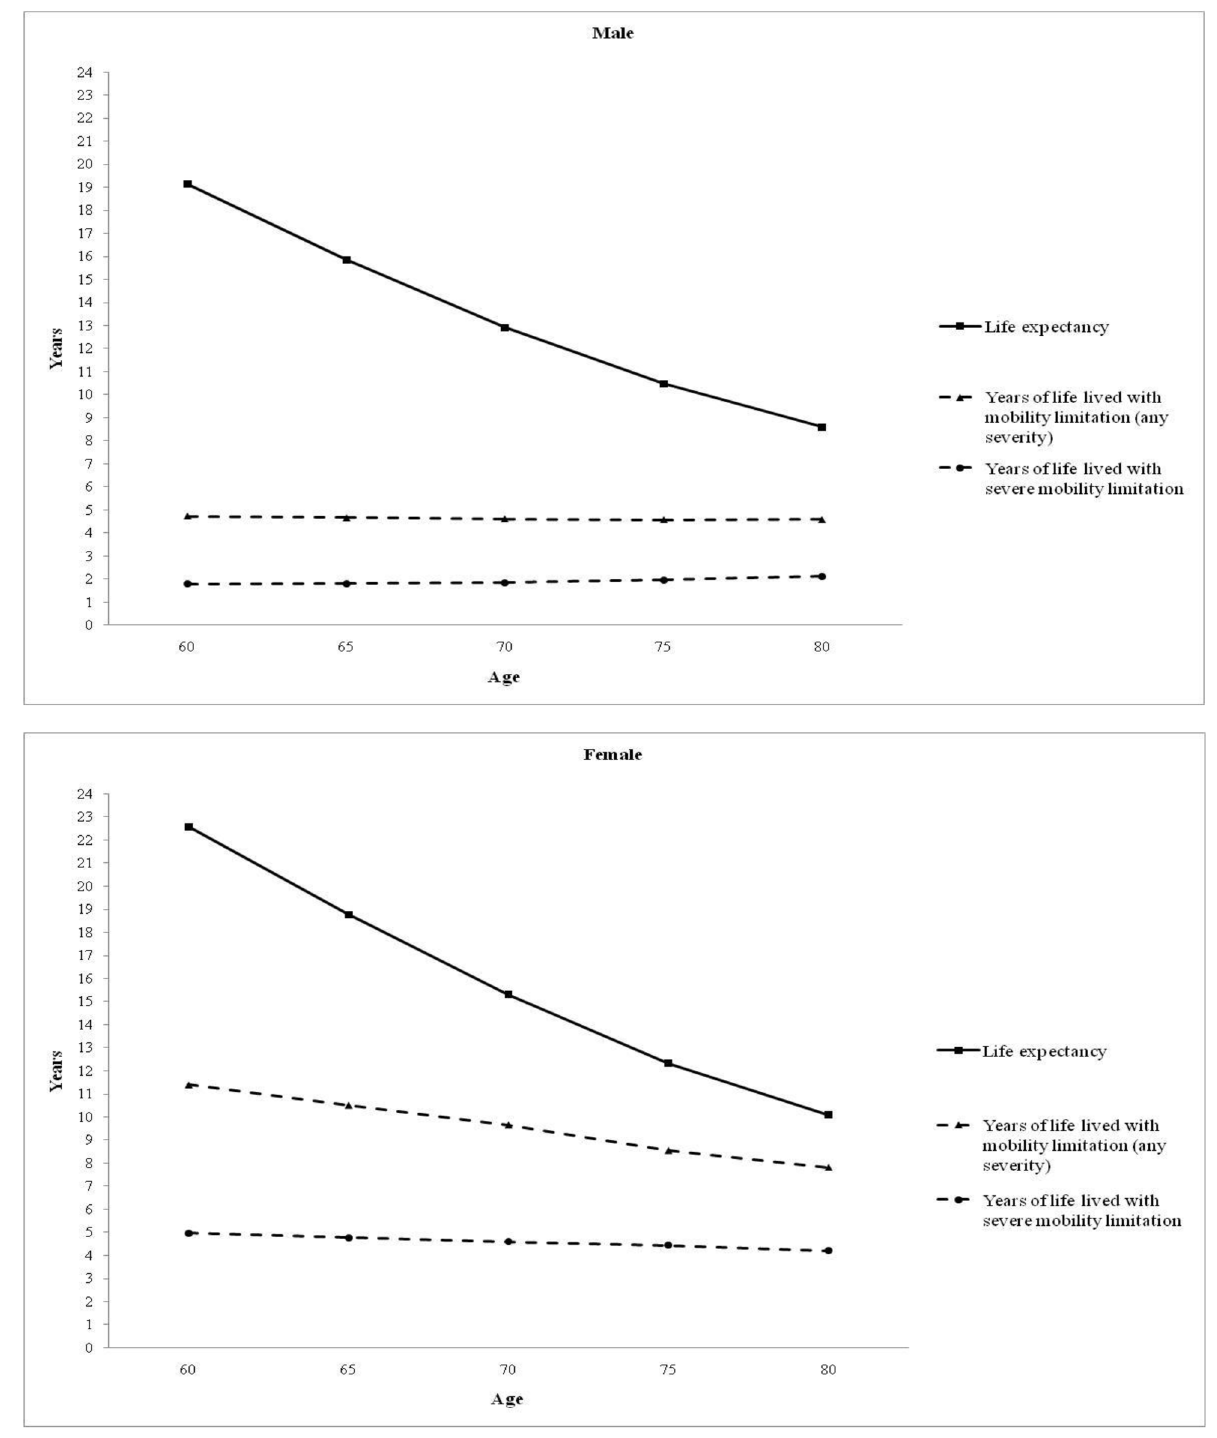
Fig 1. Life expectancy and years of life lived with mobility limitation at age 60, 65, 70, 75, and 80 in Thailand, 2009. Mobility limitation (any severity) was defined as having inability (complete or partial) to do at least one of (i) walking at least 400 meters without resting, and (ii) going up or down a flight of 10 stairs without resting without human assistances or technical aids. Mobility limitation (severe level) was defined as complete inability to do at least one of these two functions, even with assistances or aids.